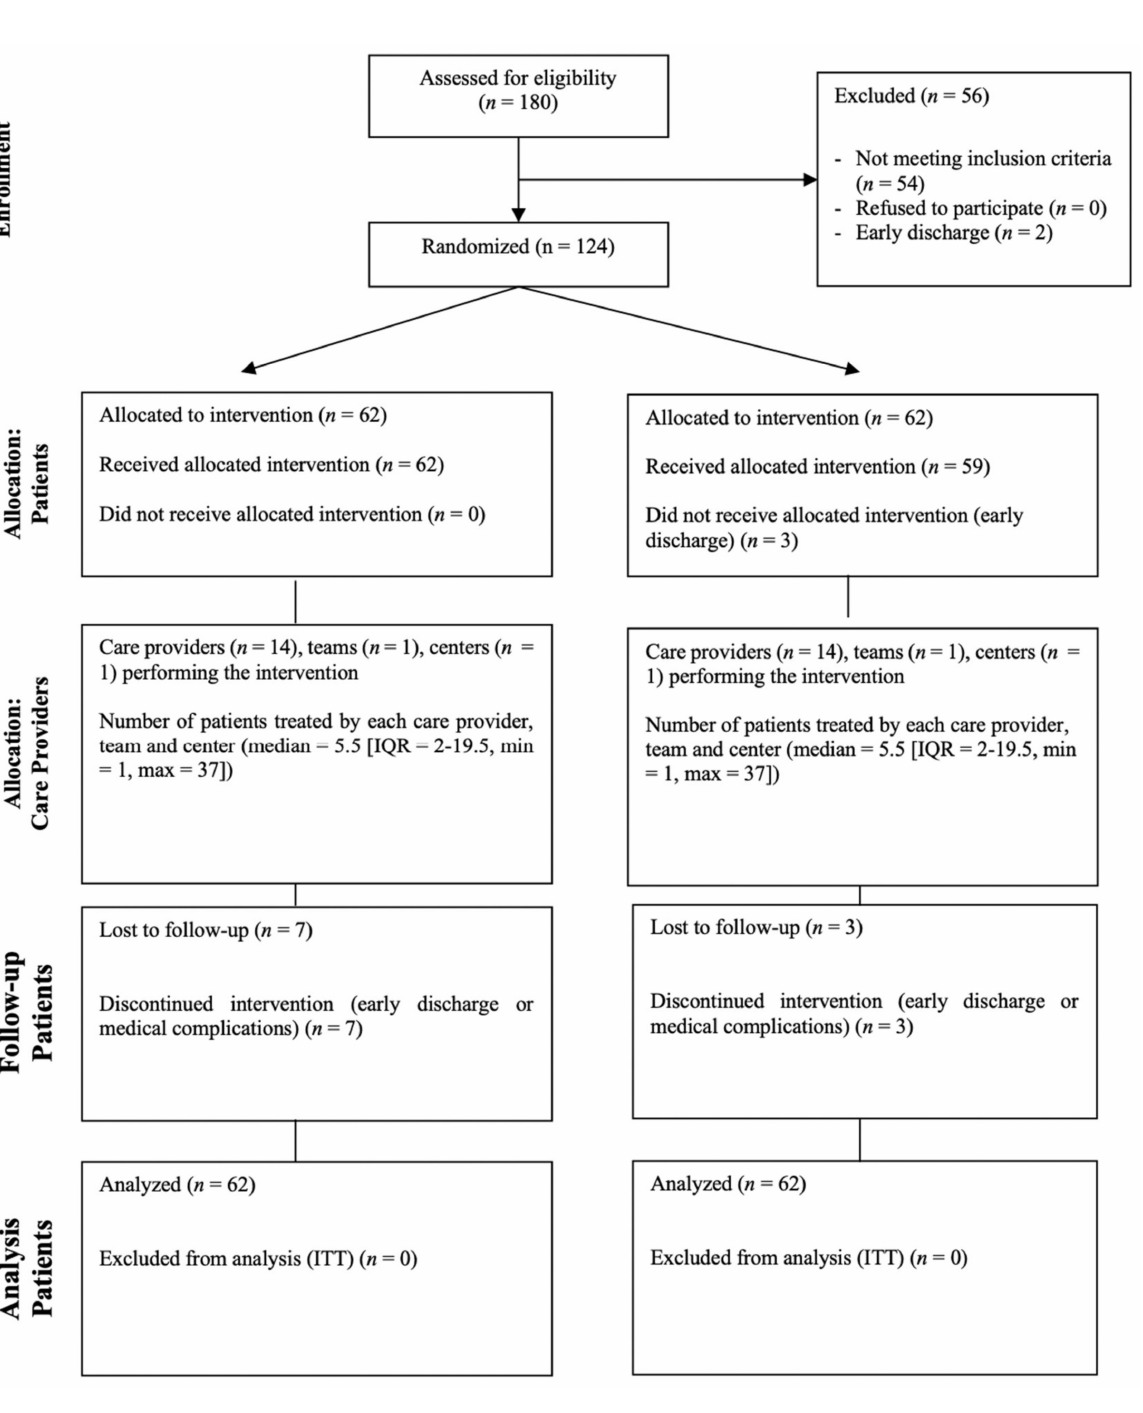
Figure 4. Modified CONSORT flow diagram for individual randomized controlled trials of nonphar- macologic treatments. IQR = interquartile range; max = maximum; min = minimum; n = number of